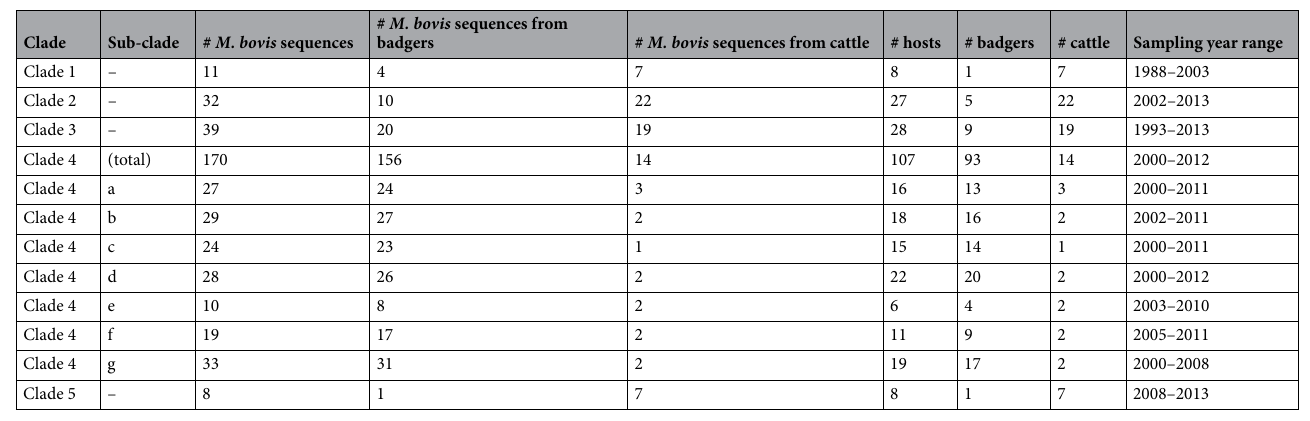
Table 1. Woodchester Park (UK) M. bovis sequences and clades (based on Crispell et al. 36